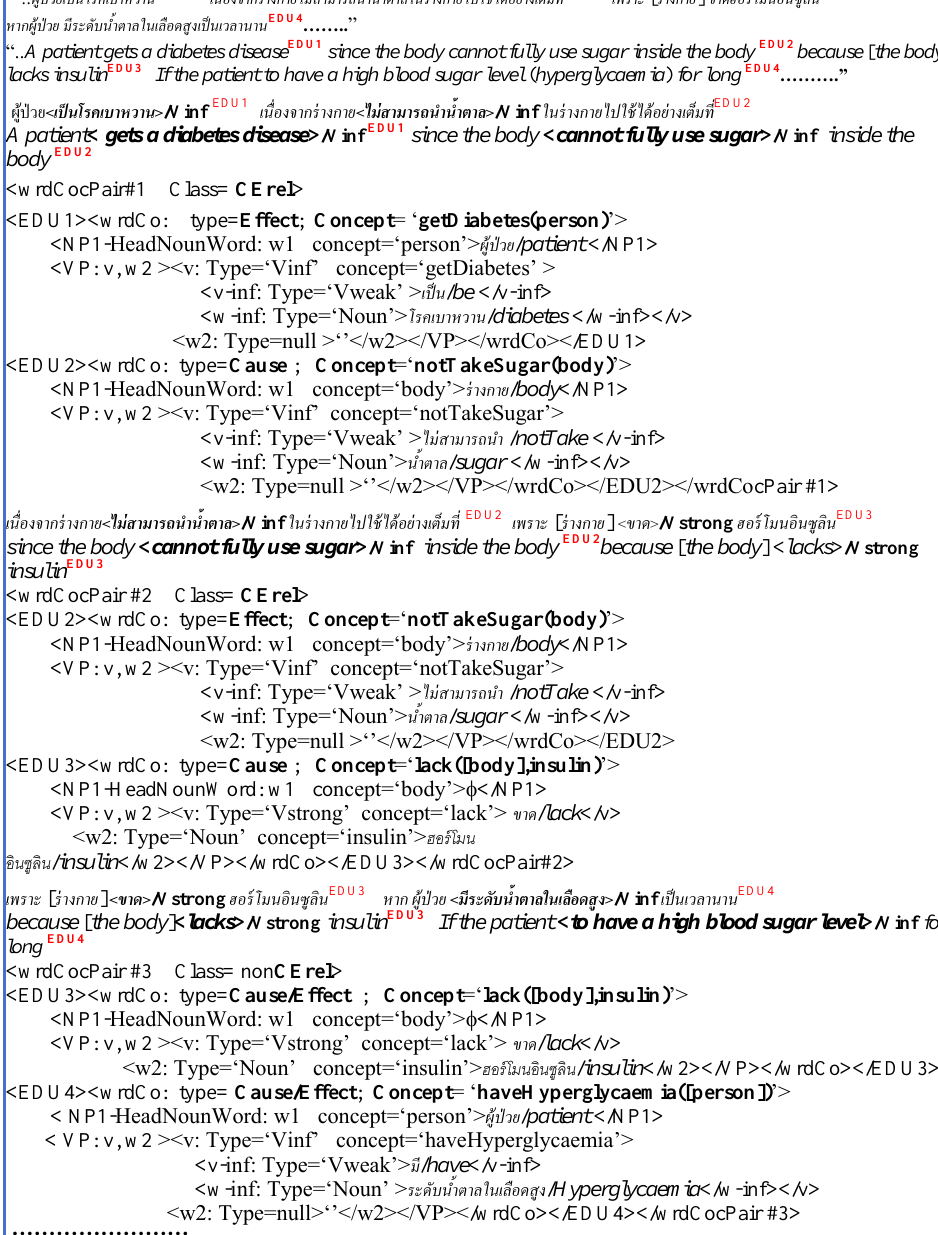
Figure 6. Annotation of wrdCo concepts or wrdCoc features including CErel/nonCErel Class be- tween wrdCoc pair where v, w1, and w2 symbols in a wrdCo tag is v a , w 1, d , and w 2,e terms/elements respectively of wrdCoPattern.